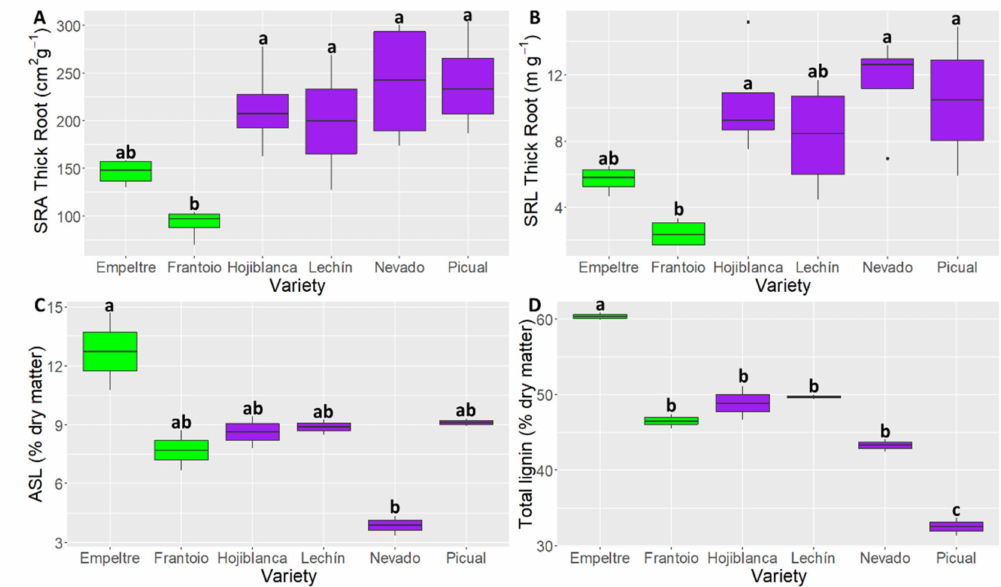
Figure 3. Boxplots showing median values of the ANOVA analysis of the most statistically significant root traits: SRA Thick Root (‘Thick root specific area’) ( A ), SRL Thick Root (‘Thick root specific length’) ( B ), ASL (‘Acid soluble lignin’) ( C ) and ‘Total lignin content’ ( D ). Tolerant cultivars are represented in green color while the susceptible ones are shown in purple color. Letters indicate Tukey HSD post hoc tests at the p < 0.05 level, following